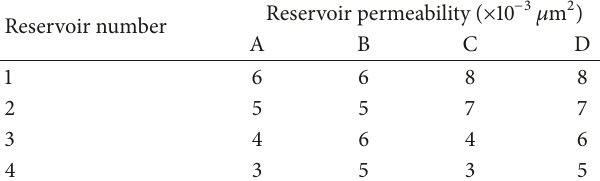
Table 5: The values of reservoir permeability.